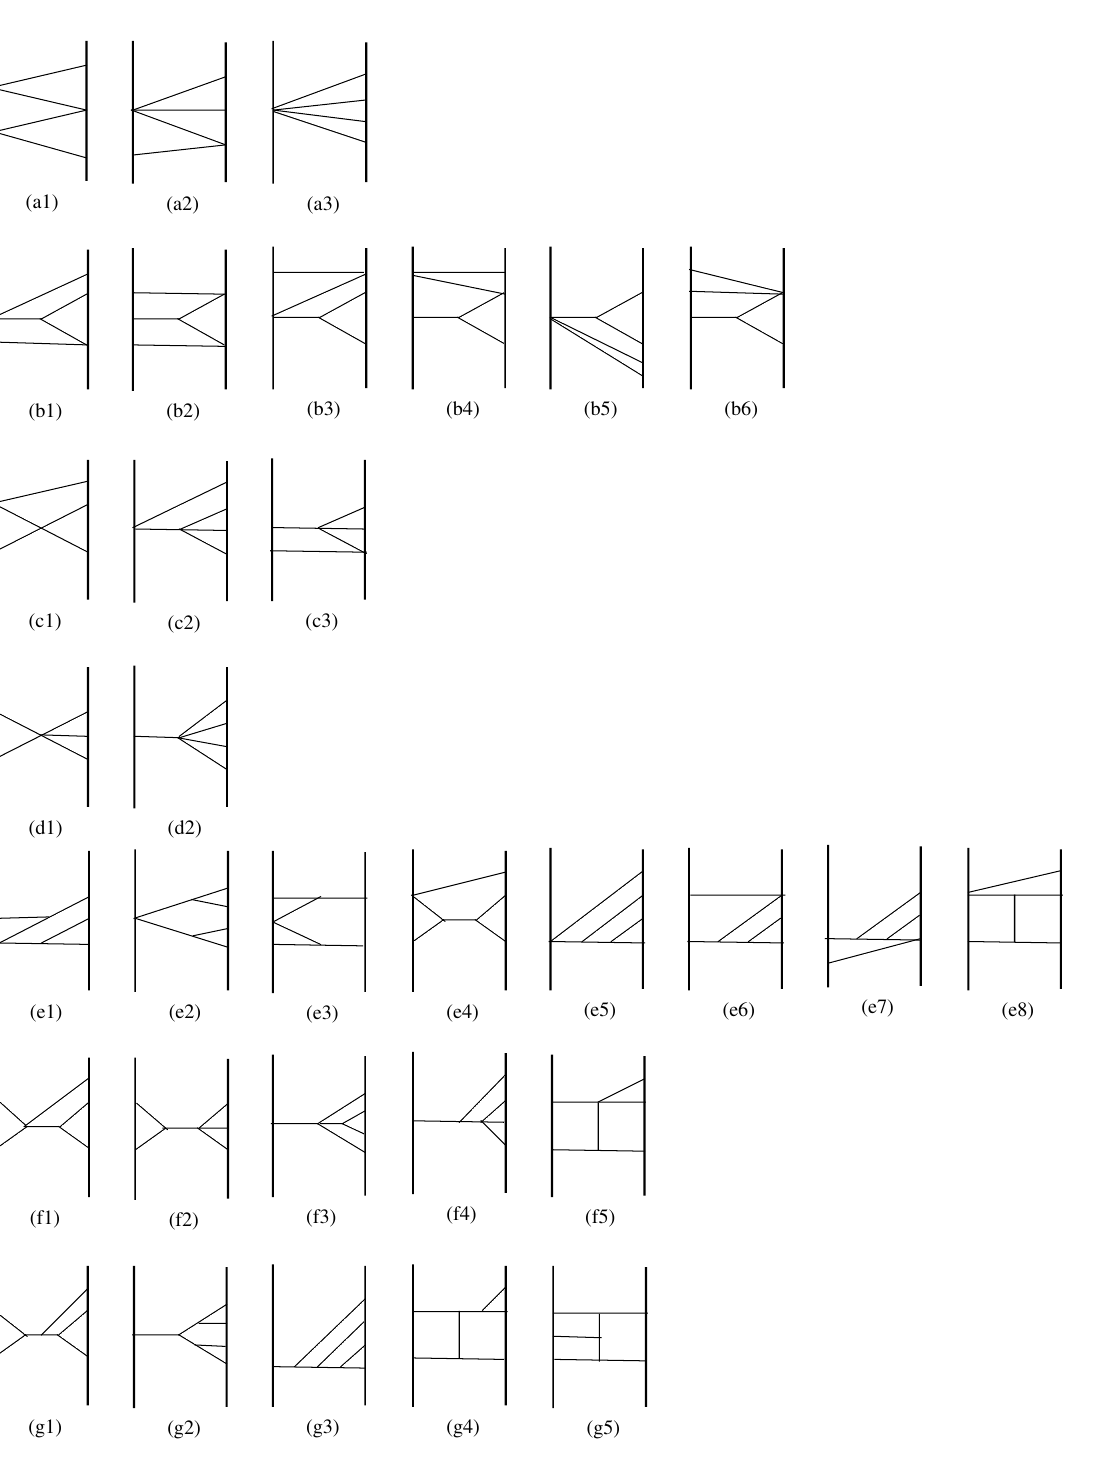
Figure 4 . Graph topologies at order G 4 : (a) No self-interaction vertices. (b) One cubic vertex. (c) One quartic vertex. (d) One quintic vertex. (e) Two cubic vertices. (f) One cubic vertex and one quartic vertex. (g) Three cubic